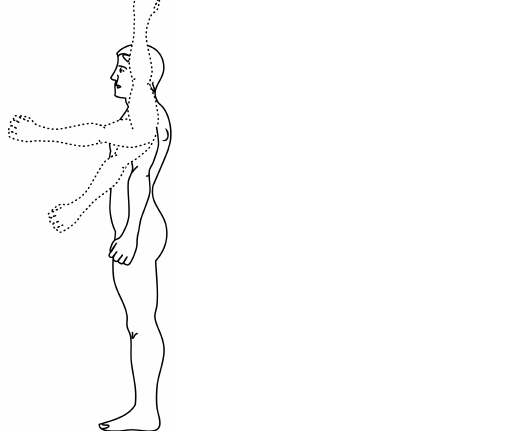
Figure 3. An example image illustrating the variations in the appearance of human arm due to large articulation